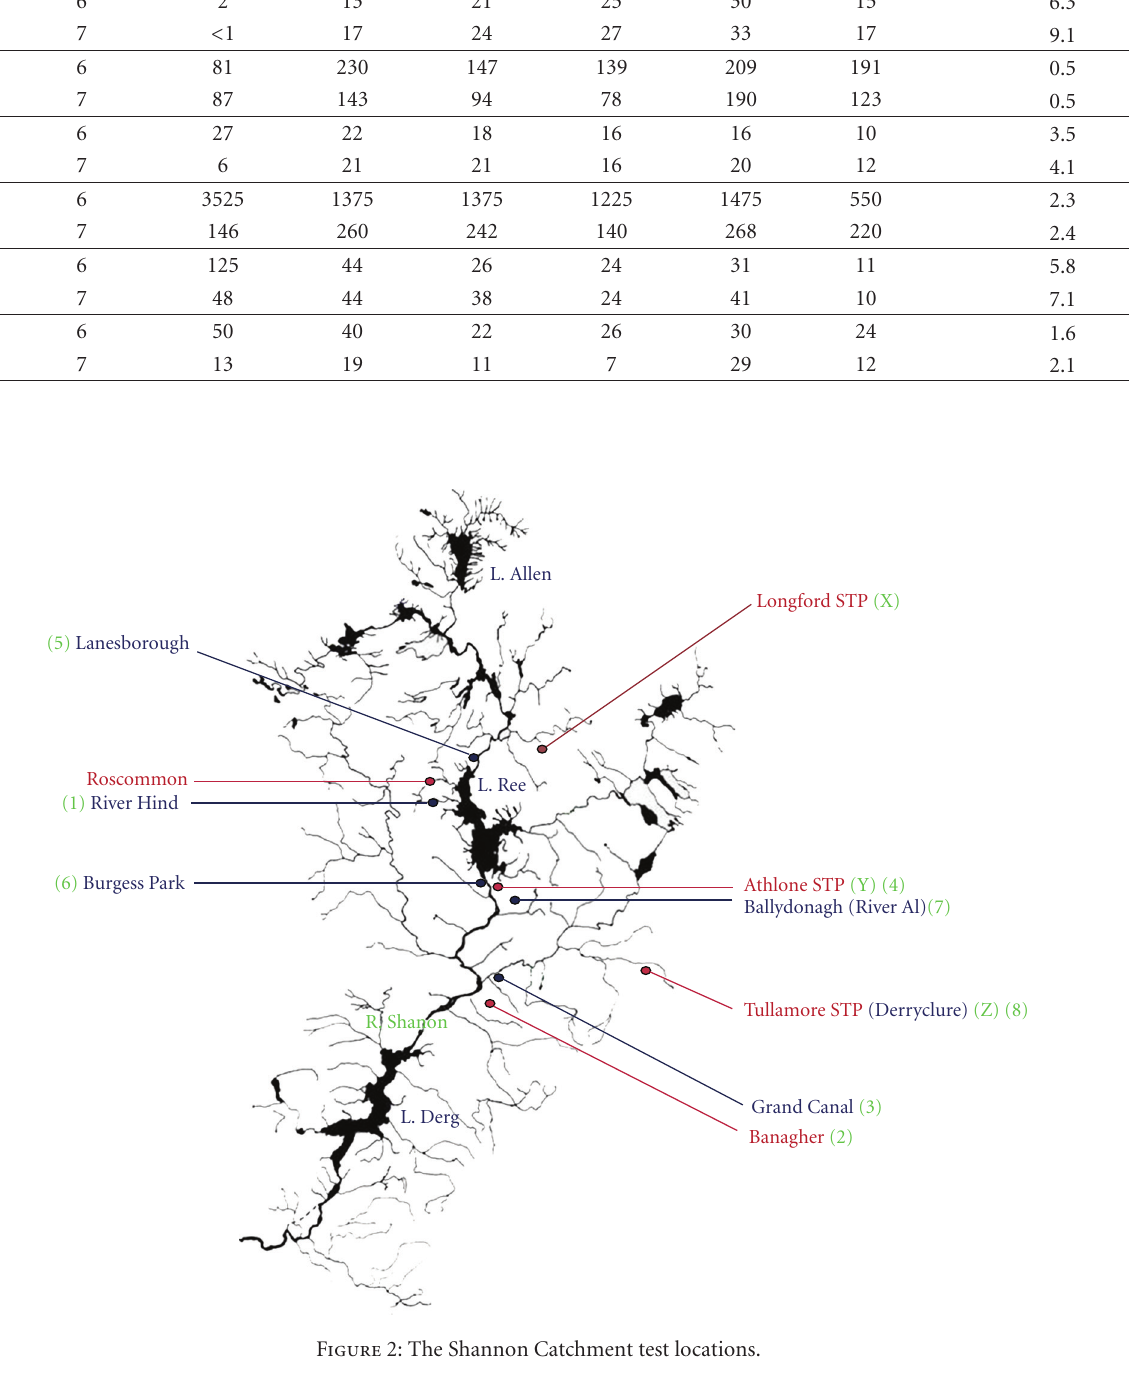
Table 4: Metal content in leachate sediment in the Irish Midlands Region (mg/kg Metal Site no.